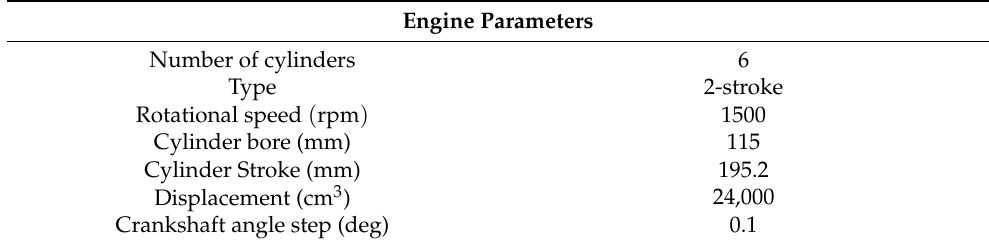
Table 2. The parameters of the six-cylinder, two-stroke, opposed-piston engine